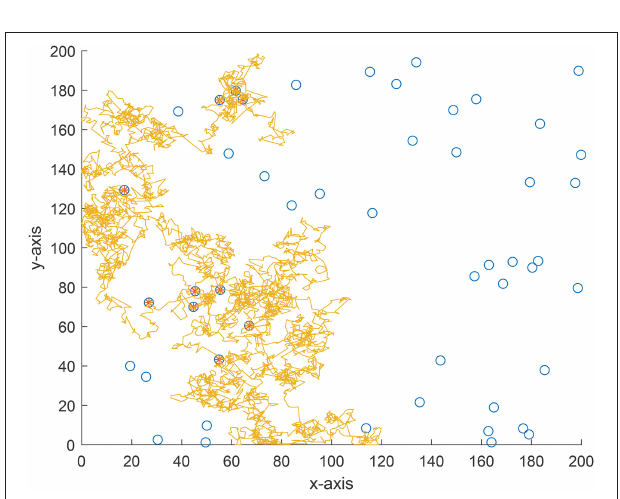
FIGURE 8 | A typical example of foraging procedure with λ = 0.5 and µ =